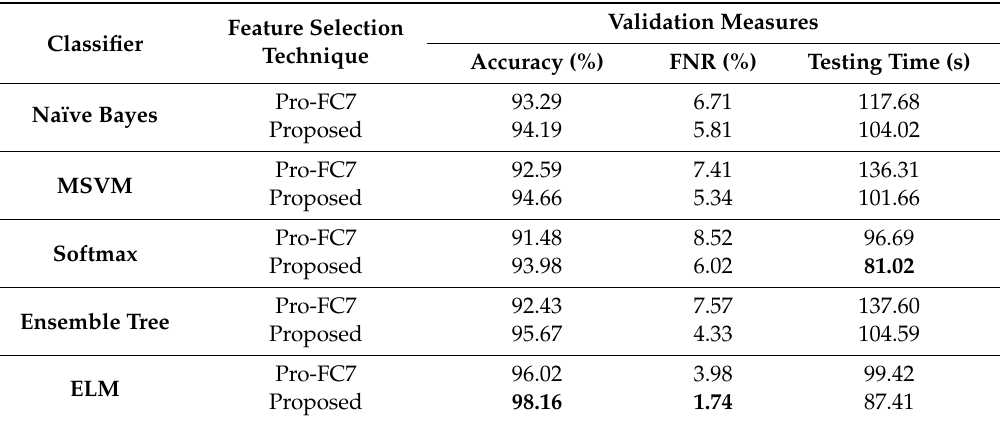
Table 1. Classification results for the BraTS 2015